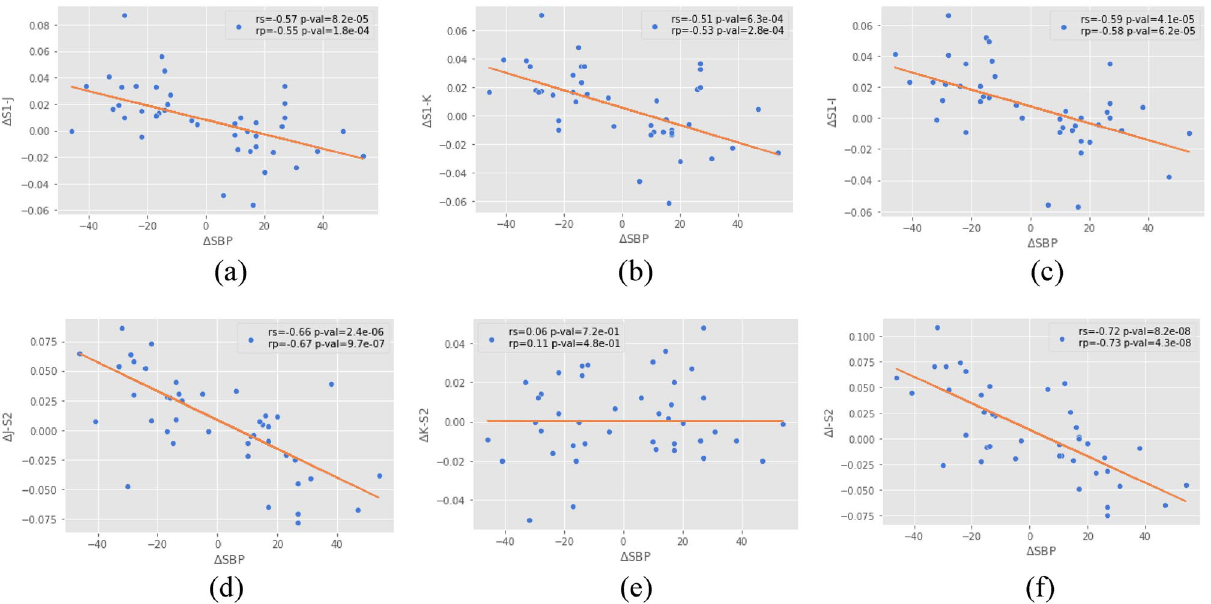
Figure 5. Scatter plots of time intervals against SBP changes in the features for different states. rs = Spearman correlation coefficient; rp = Pearson correlation coefficient. D 1